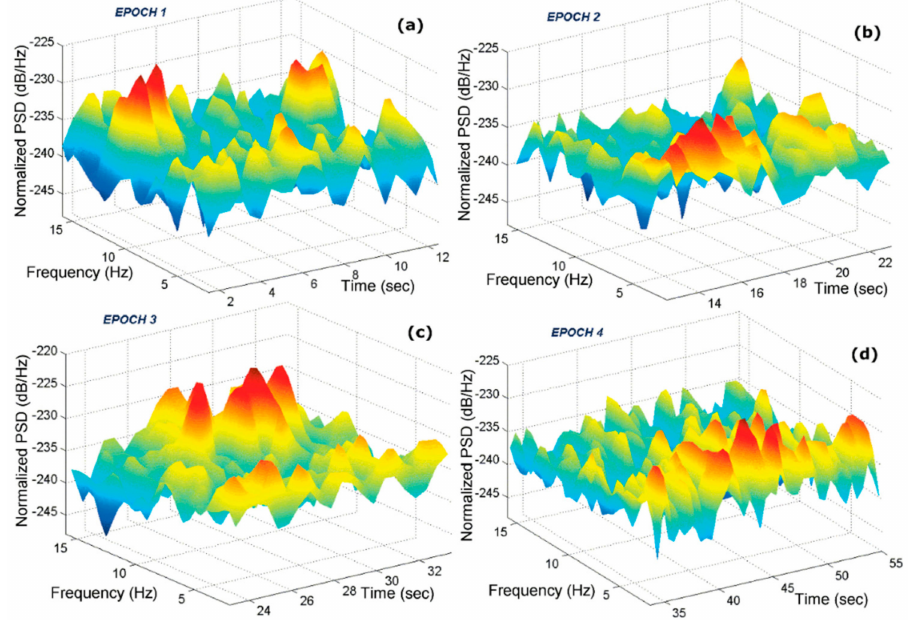
Figure 6. Time–frequency analysis of the magnetoencephalography (MEG) from a representative subject. ( a – d ) The graphs show the data parsed into epochs. Notice that Epochs 1 and 3 are dominated by alpha ( a , c ), whereas Epochs 2 and 4, corresponding to periods of navigation, are dominated by theta ( b , d ). All rights reserved, with permission from the Massachusetts Institute of Technology. Reference